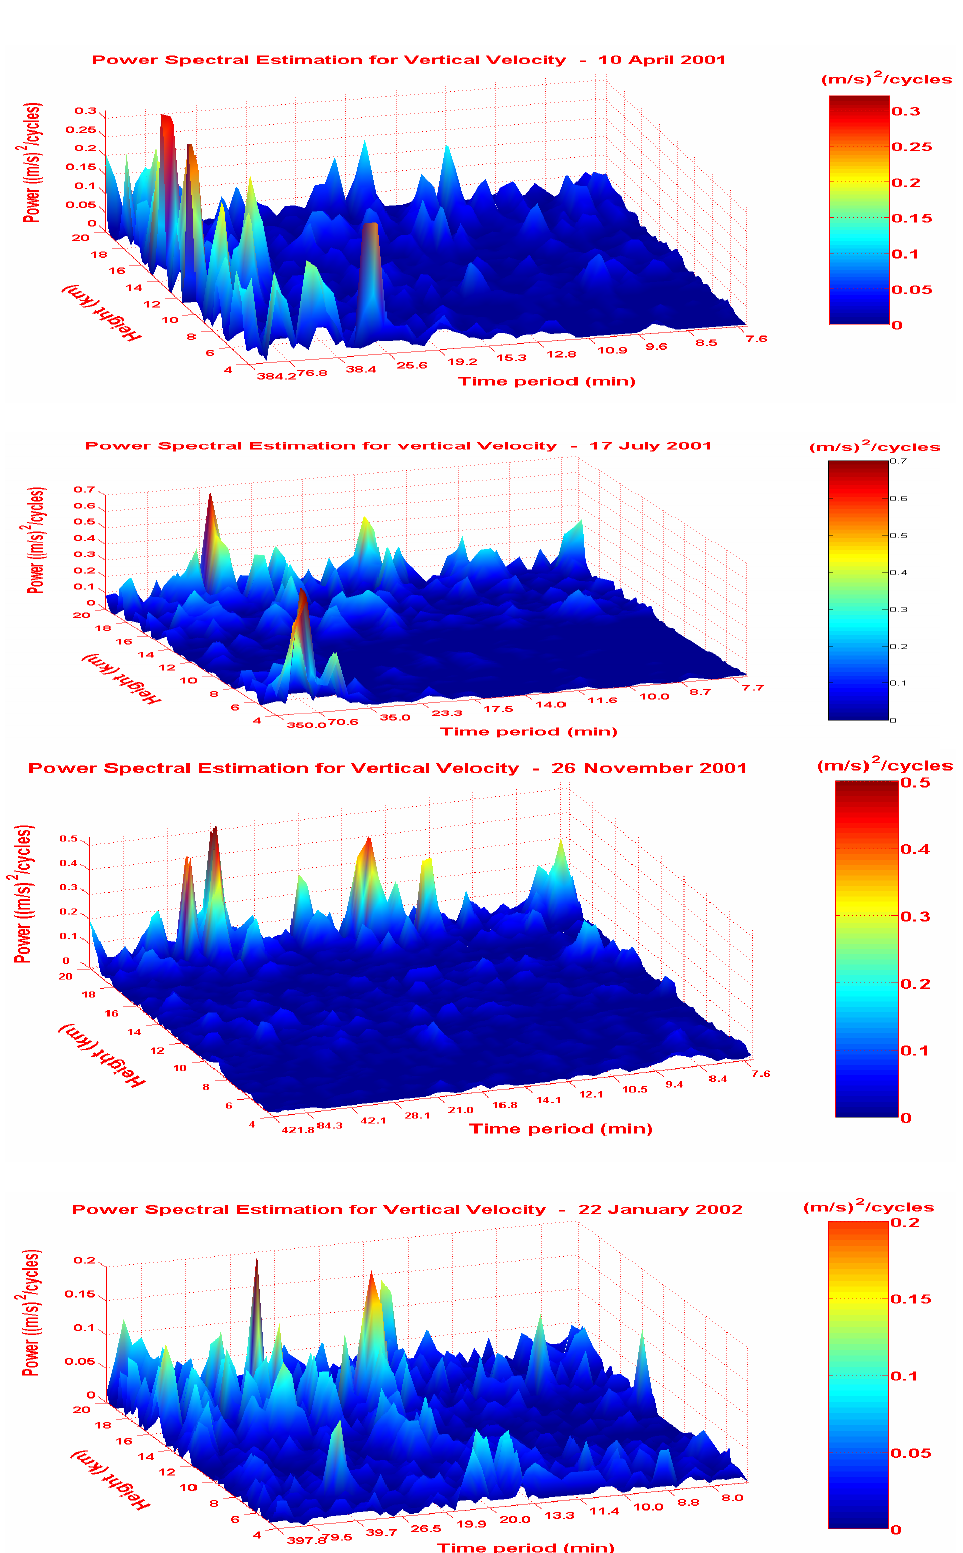
Fig. 10. Fig. 10. Same as Fig. 8, but for the vertical velocity during the same